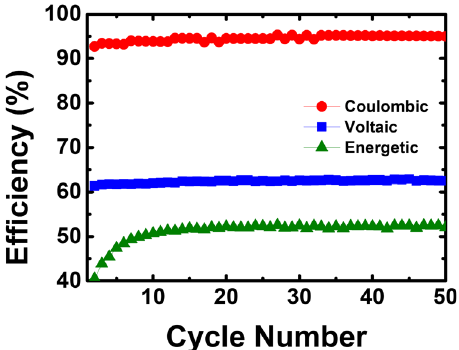
Fig. 11 Cycling ef fi ciencies vs. cycle number. Coulombic ef fi ciency, voltaic ef fi ciency, and energetic ef fi ciency plots of neutral pH aqueous all-organic active materials for RFB single cell using 0.1 M of TRYP-SO 3 H as anolyte and 0.1 M of BQDS as catholyte in 1.0 M KCl as supporting electrolyte.